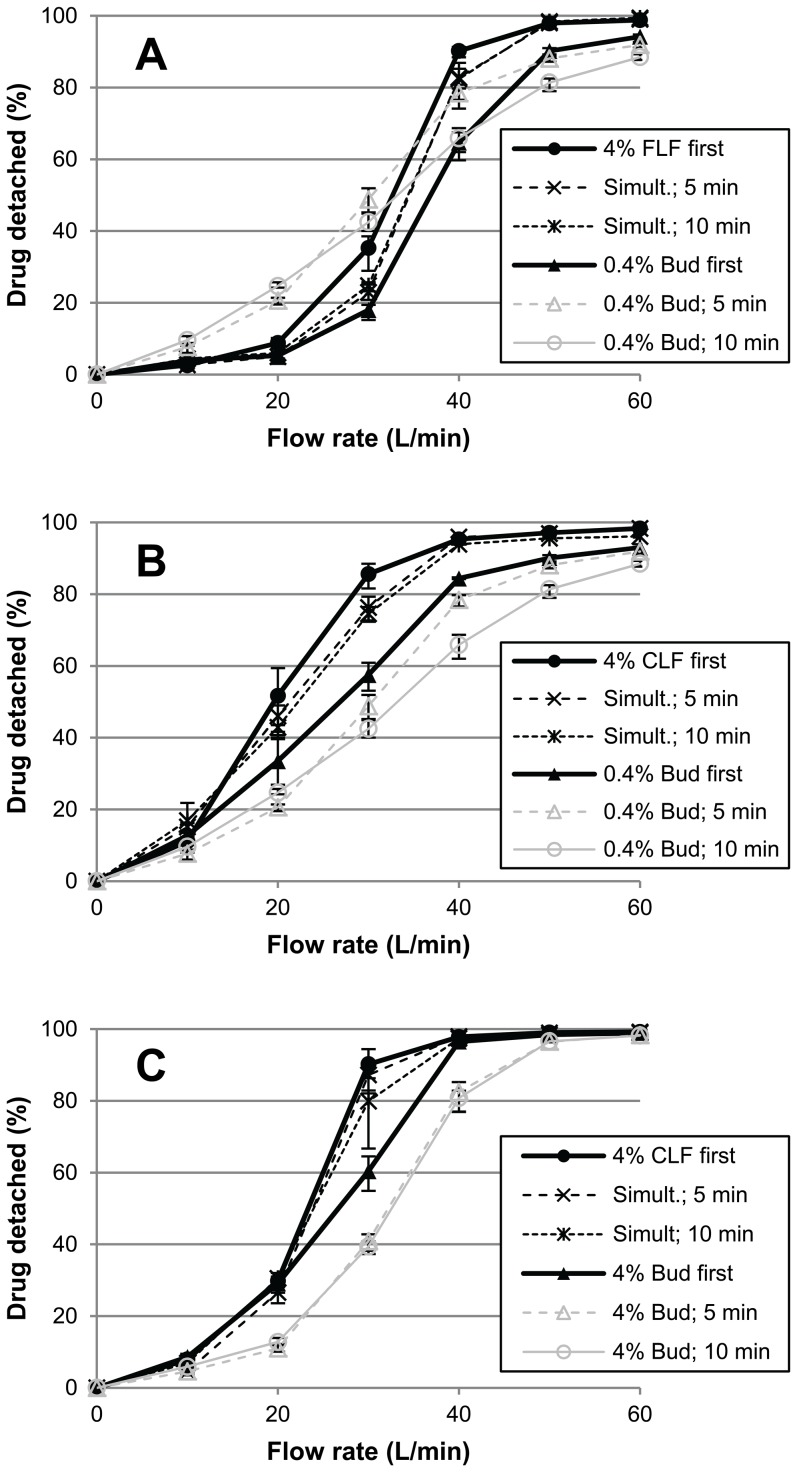
The influence of mixing order on the effects of added fines on drug detachment.
A) mixtures containing 0.4% budesonide and 4% fine lactose fines (FLF); B) mixtures containing 0.4% budesonide and 4% coarse lactose fines (CLF); C) mixtures containing 4% budesonide and 4% CLF. Drug detachment versus flow rate profiles of mixtures containing only 0.4% or 4% of budesonide (mixed for 5 or 10 minutes) are shown as a reference. Fine components were mixed separately by mixing one component with the carrier for 5 minutes, after which the second component was added and mixing was continued for another 5 minutes. Simult.  =  drug and fines mixed simultaneously with the carrier material for 5 or 10 minutes. Error bars represent maximum and minimum values measured (n = 5).